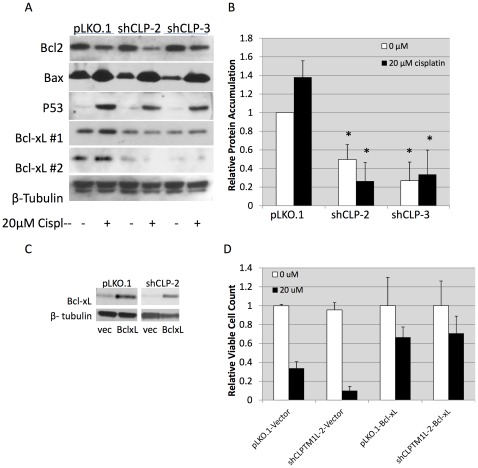
Modulation of Bcl-xL expression is required for apoptotic effects of CLPTM1L.A) Western blotting for apoptotic regulators in A549 cells with CLPTM1L knockdown after treatment with cisplatin showing decreased Bcl-xL expression upon loss of CLPTM1L. Bcl-xL blots for two separate representative clonal populations of A549 cells with CLPTM1L knockdown (#1 and #2) are shown. B) Graphic representation of Bcl-xL expression in cells with CLPTM1L knockdown from three separate clonal populationsA549. Error bars represent one standard deviation from the mean. * - p<0.003 by Student’s T-Test C) Western blots confirming expression of exogenous Bcl-xL in A549 cells with CLPTM1L knockdown. D) Relative viable cell counts in A549 cells with CLPTM1L knockdown and ectopic Bcl-xL expression after treatment with cisplatin demonstrating the abolition of apoptotic effect of CLPTM1L loss upon ectopic Bcl-xL expression.